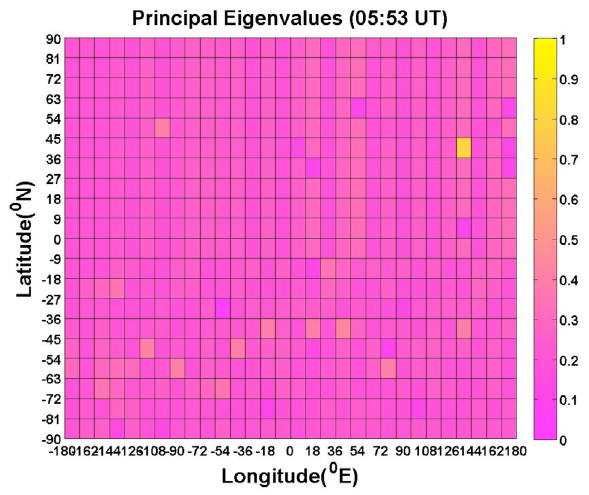
Figure 6. The figure gives a color-coded scale of the magnitudes of principal eigenvalues corresponding to Figure 3.